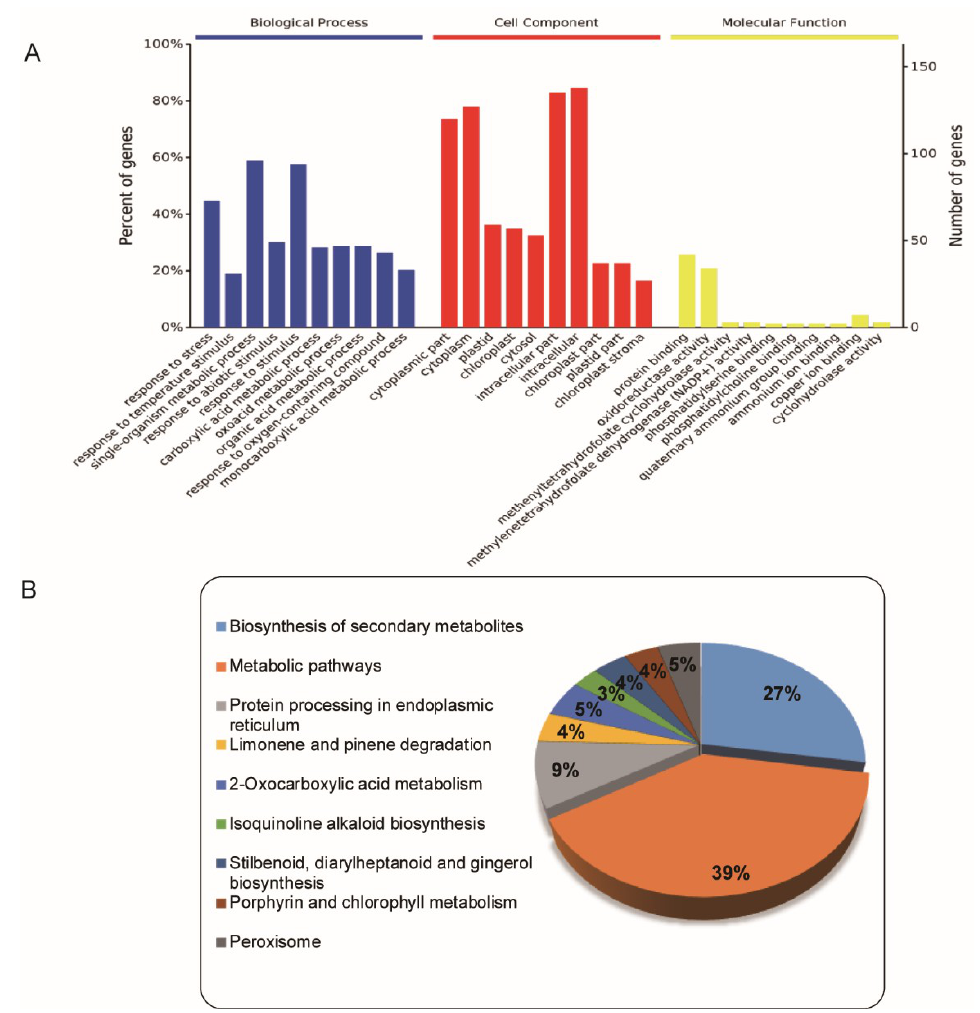
Figure 4. Summary of 172 proteins that were upregulated in LT and HT treatments. ( A ) Histogram of GO classification of upregulated proteins under both treatments. ( B ) Percentage of the 172 upregulated proteins in each KEGG pathway.